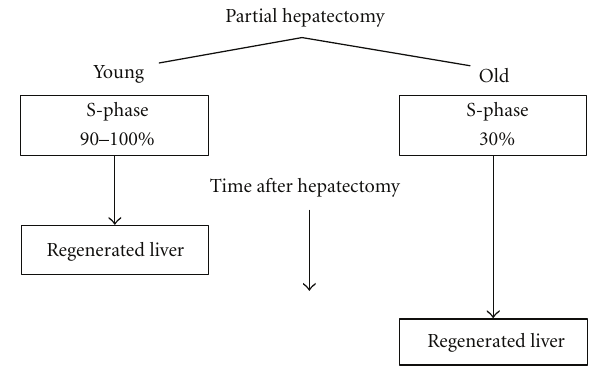
Figure 2: E ff ect of age on the number of hepatocytes entering S-phase and the rate of liver regeneration following partial hepa-